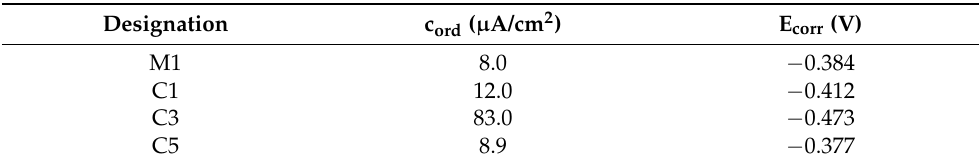
Figure 11. Potentiodynamic polarization curves of laser-cladded coatings M1, C1, C3 and C5; designations in accordance with Table 3. Table 6. Electrochemical parameters of the laser-cladded coatings, designations in accordance with Table